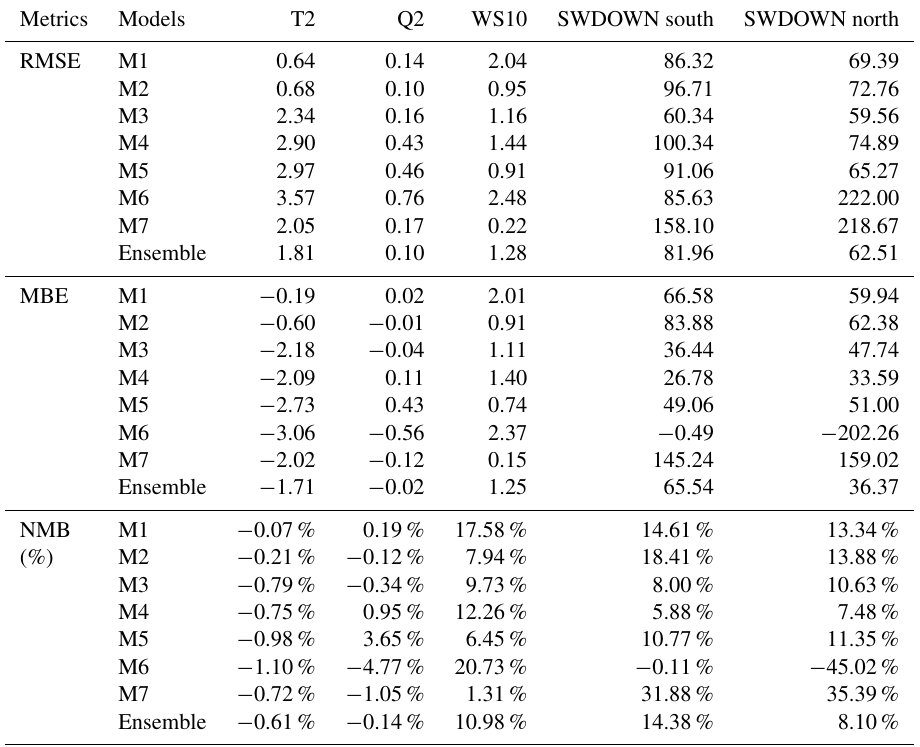
Table 3. Performance statistics of meteorology variables (RMSE and MBE units: degree for T2; gkg − 1 for Q2; ms − 1 for WS10; Wm − 2 for